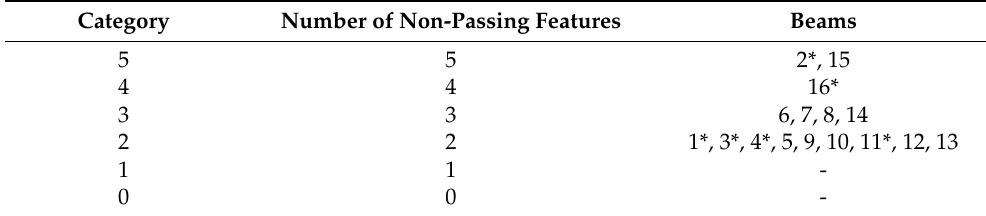
Table 8. Categories of damaged beams depending of the number of non-passing features. With * are the beams at which acoustic emission associated with active xylophages was detected. Category Number of Non-Passing Features Beams 5 5 2*, 15 4 4 16* 3 3 6, 7, 8, 14 2 2 1*, 3*, 4*, 5, 9, 10, 11*, 12, 13 1 1 - 0 0